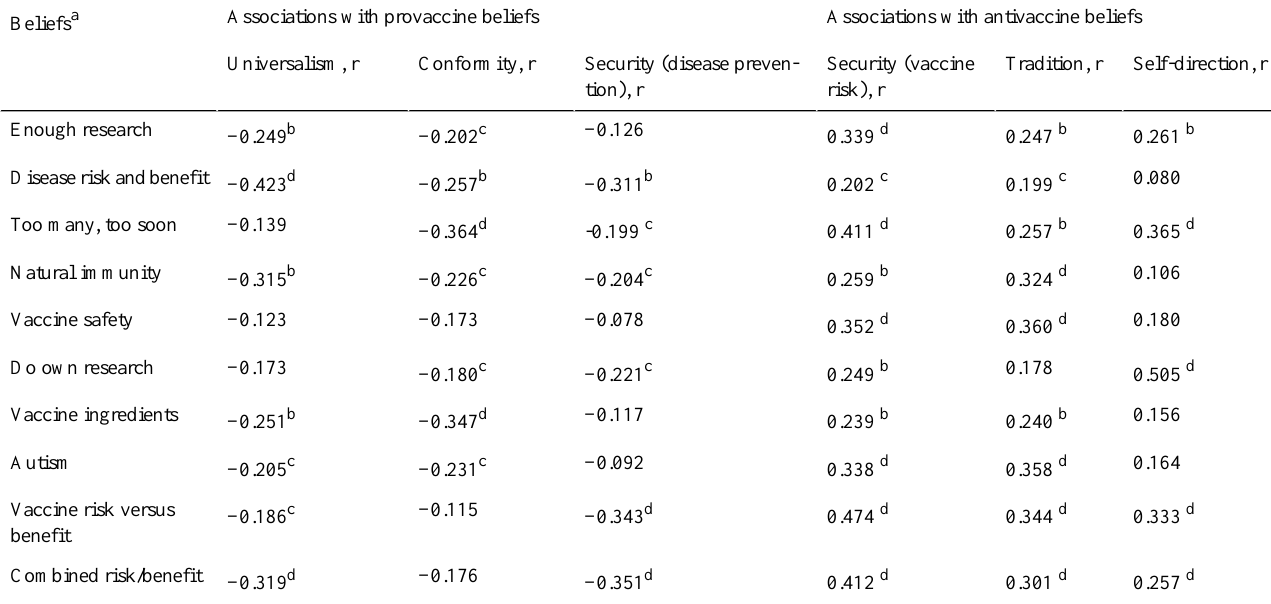
Table 3. Correlations between values and beliefs corresponding to website topic areas. Correlations (r) are Spearman correlation coefficients.